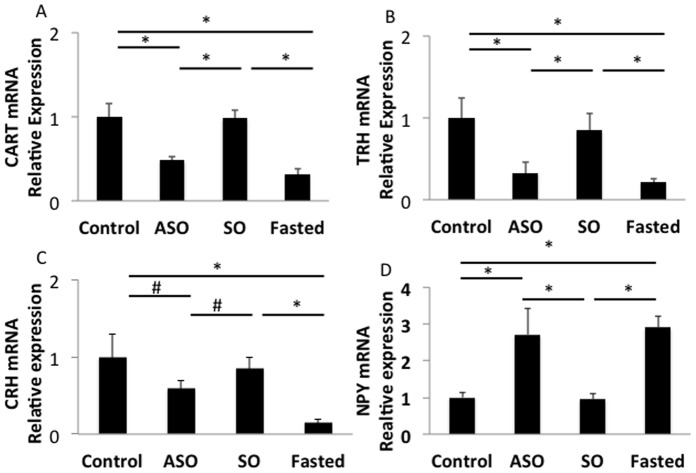
mRNA level of neuropeptides in hypothalamus from ASO-ACC and ACC-SO mice.Analyses of CART, TRH, CRH and NPY mRNA expression in the hypothalamus of control, ACC-ASO (ASO) and ACC-SO (SO) rats by RT-PCR. Data are means ± SEM of 8–10 rats. #p≤0.05 and *p≤0.01.